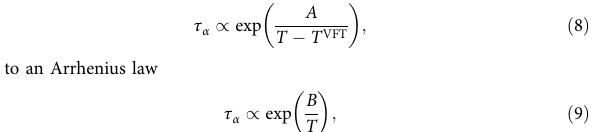
Observables . We monitor the system structure with two common liquid state quantities: the pair-distribution function g ( r ), and the structure factor S ( k ) =